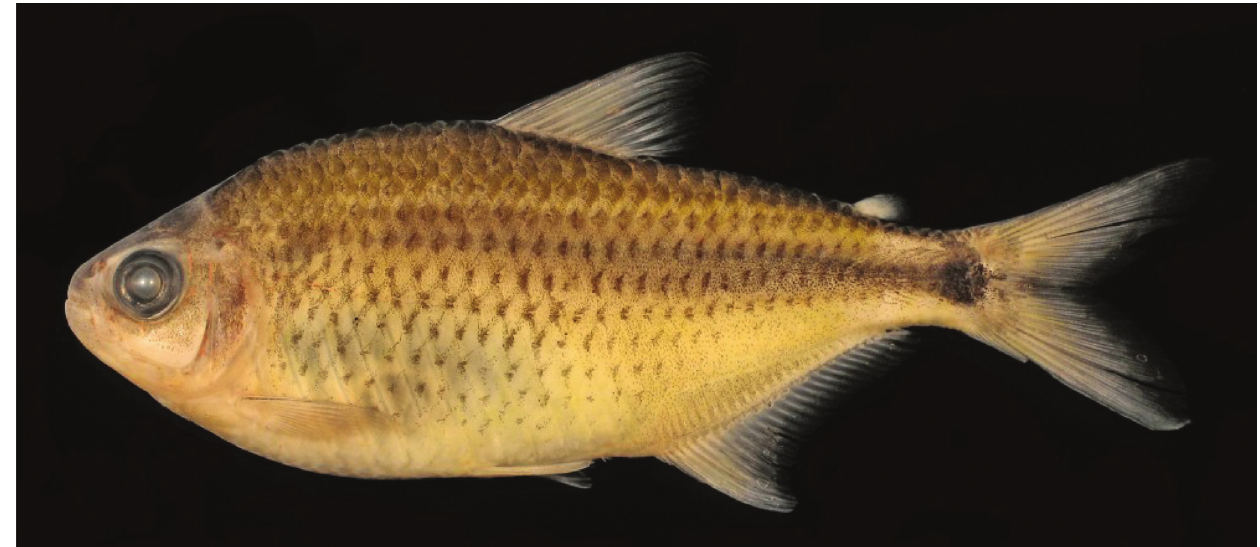
Fig. 1. Jupiaba kurua , holotype, MZUSP 98000, 77.7 mm SL, upper rio Curuá, Xingu